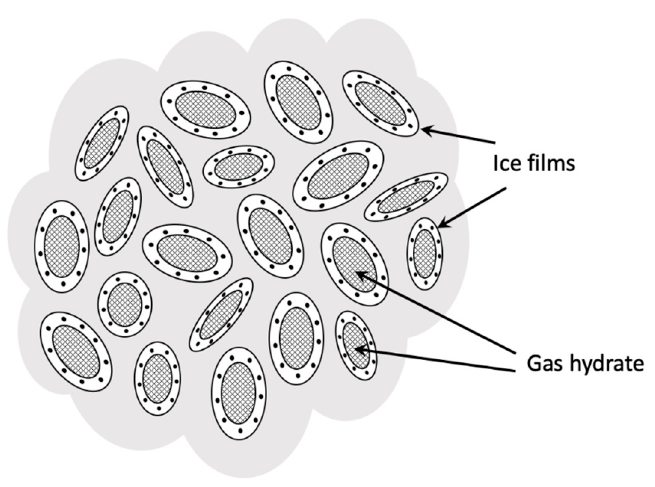
Figure 5. Metastable gas hydrate structure.